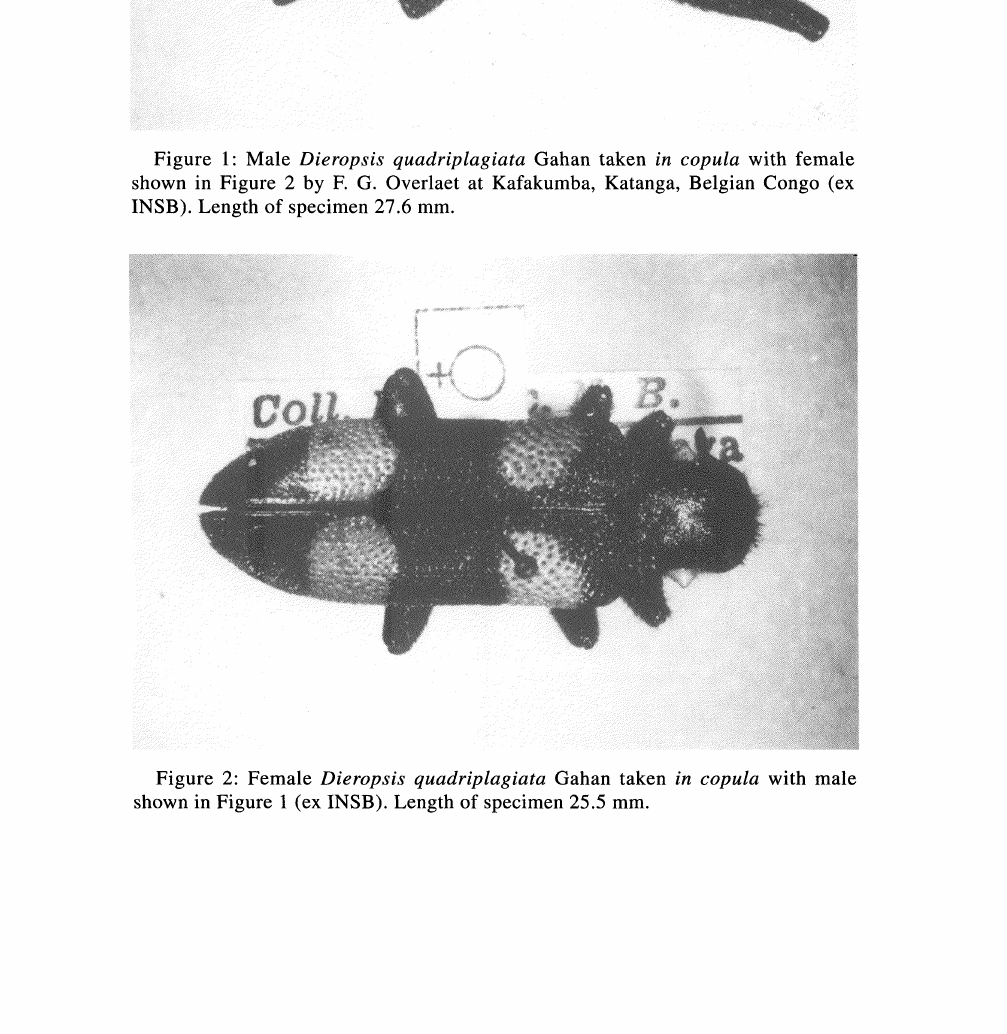
Figure 2: Female Dieropsis quadriplagiata Gahan taken in copula with male shown in Figure (ex INSB). Length of specimen 25.5